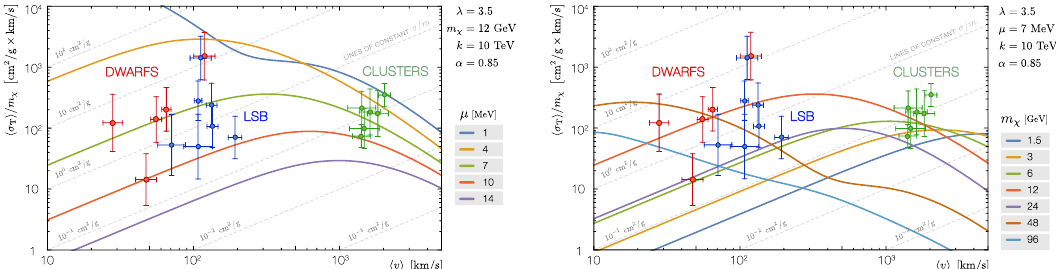
Figure 8 . Velocity dependence of the thermally averaged transfer cross section, analogous to fig- ure 7, for a range of µ and m χ choices to demonstrate the behavior with respect to these parameters. behavior from the ideal case. Figure 8 presents such a scan over the mass gap µ and m with other parameters